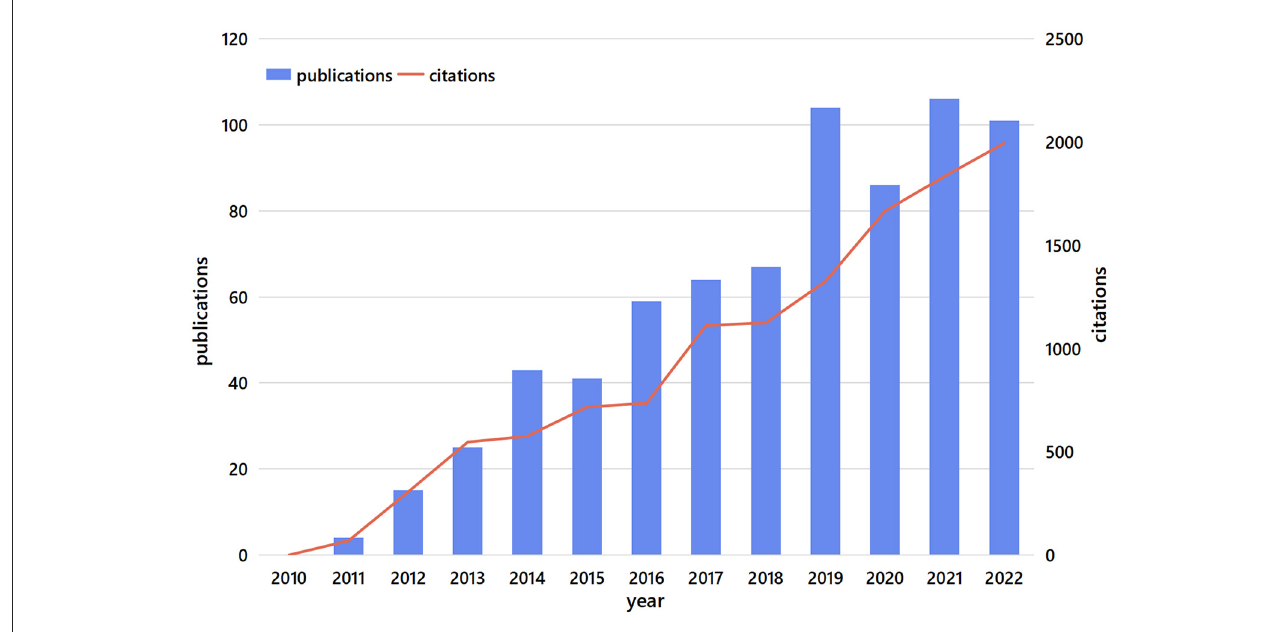
FIGURE1 Trend of publications and citations (2011–2022).